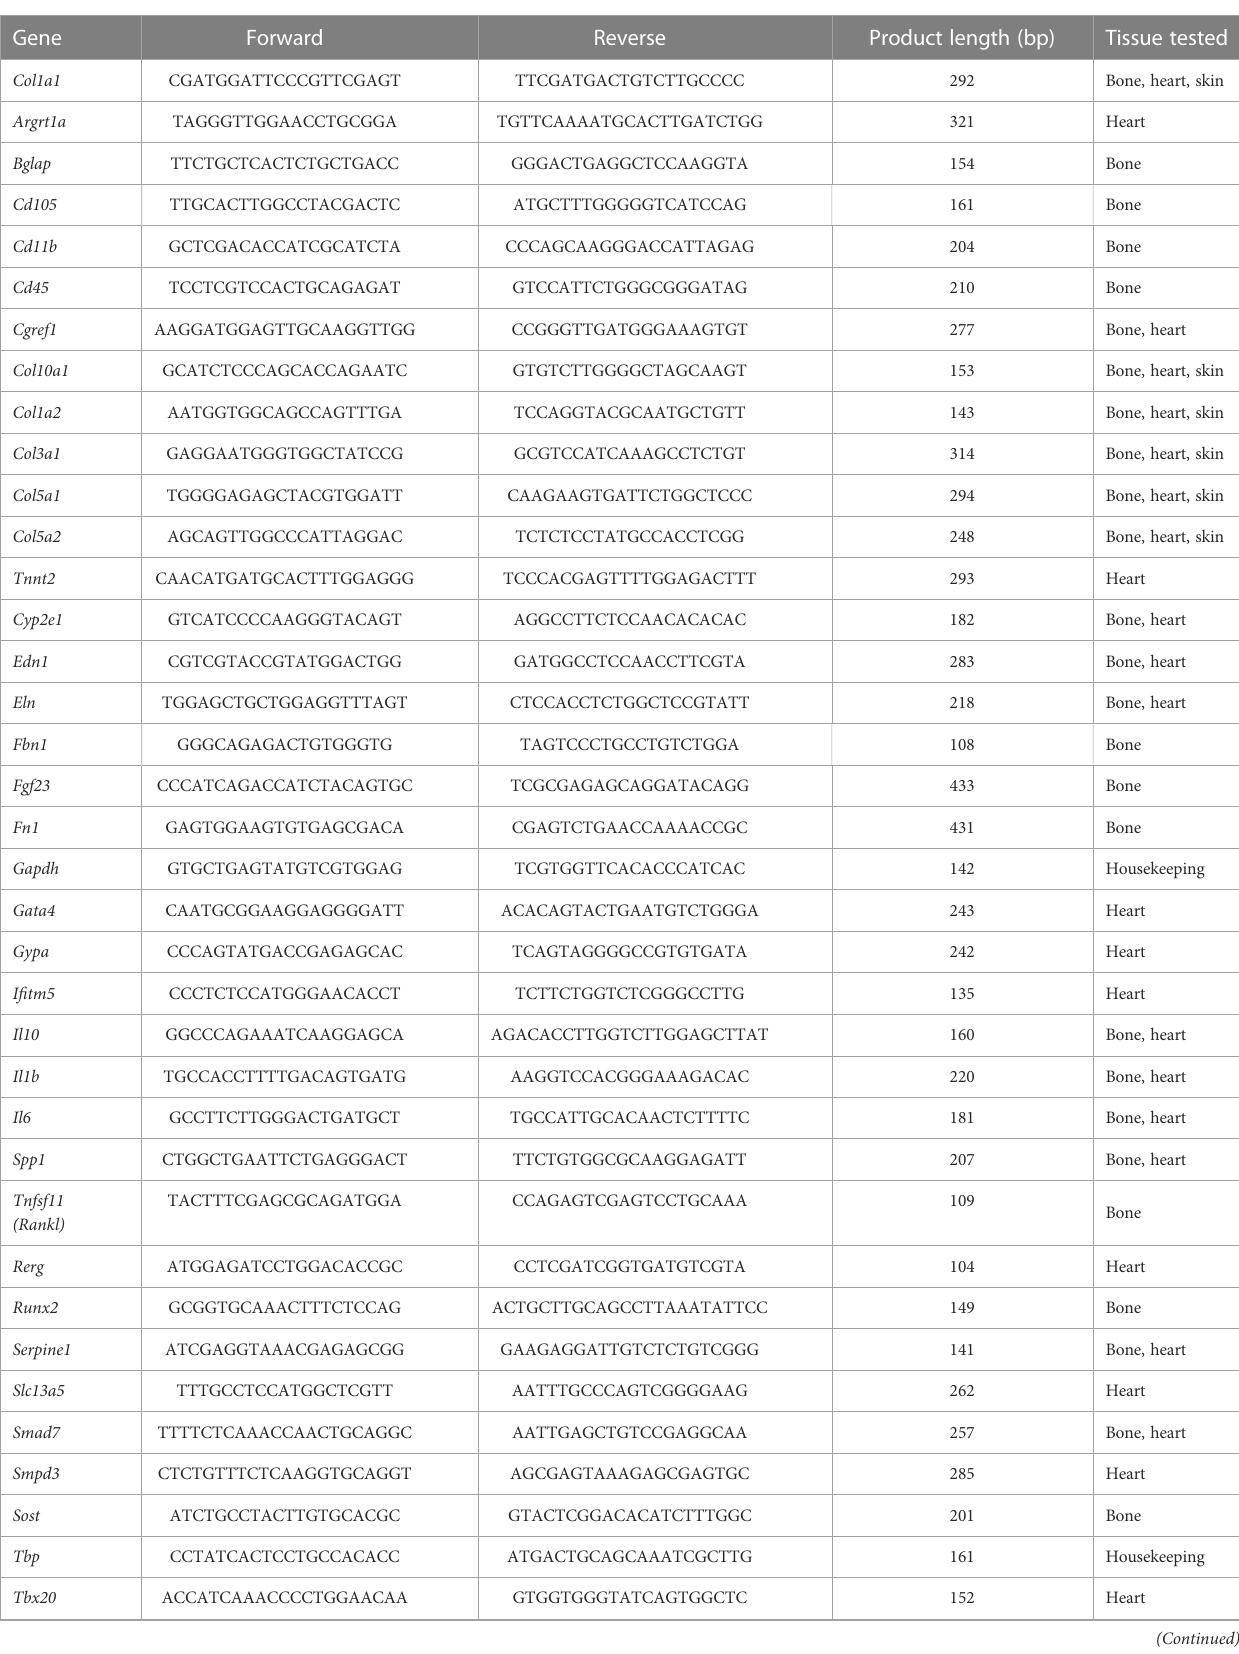
TABLE 1 Primers used in qPCR analysis and tissue, in which corresponding gene expression was tested.